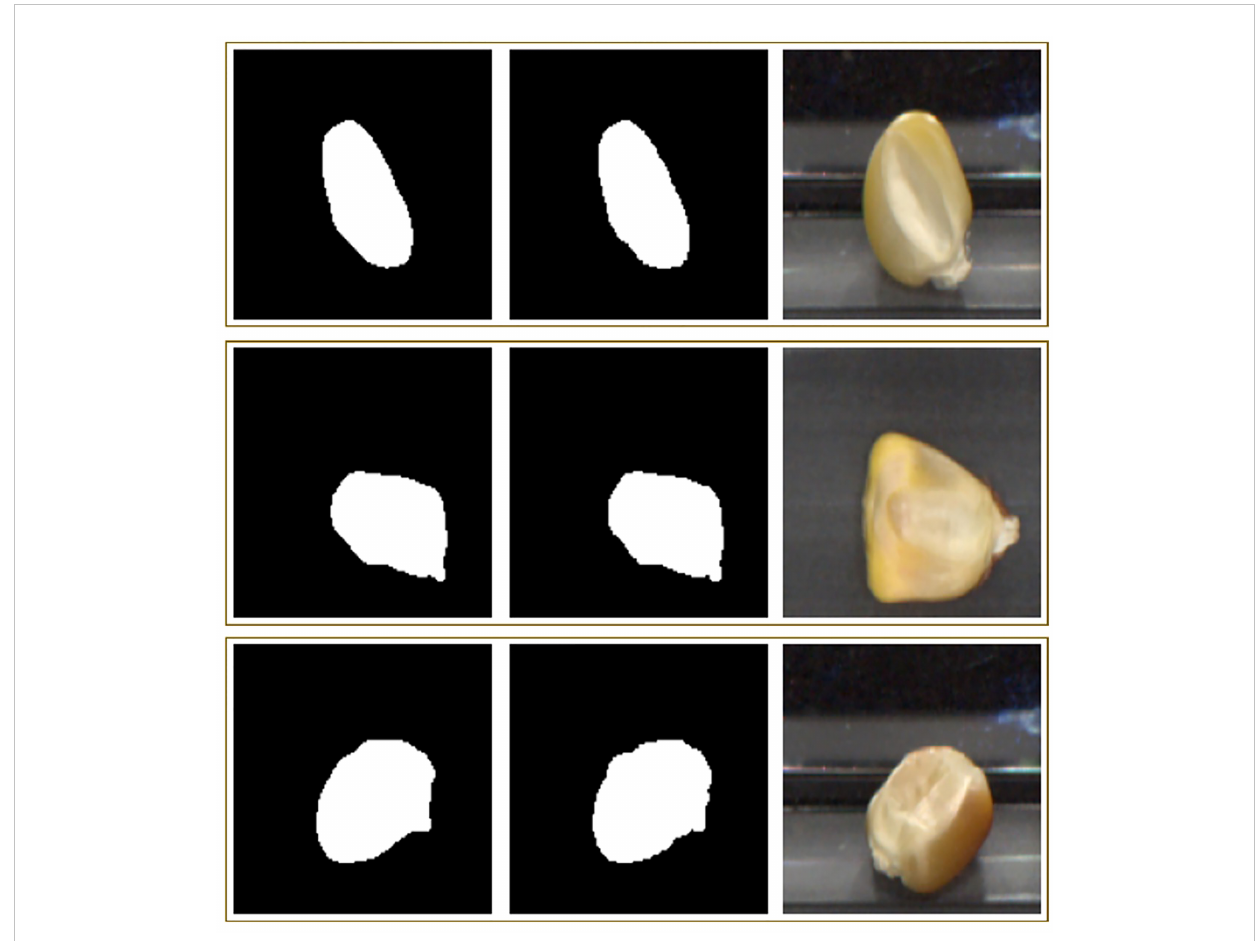
FIGURE 9 Three representative rows of segmentation inputs and outputs. The fi rst column shows the predicted mask, the second shows the true mask, and the third shows the RGB input